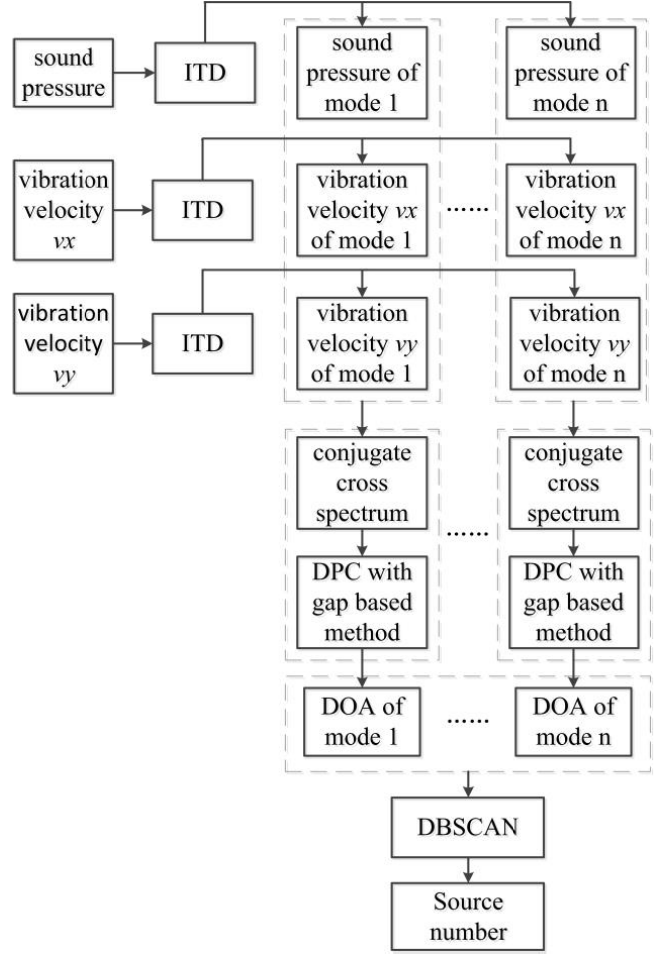
Figure 1. Flow chart of multimodal fusion.